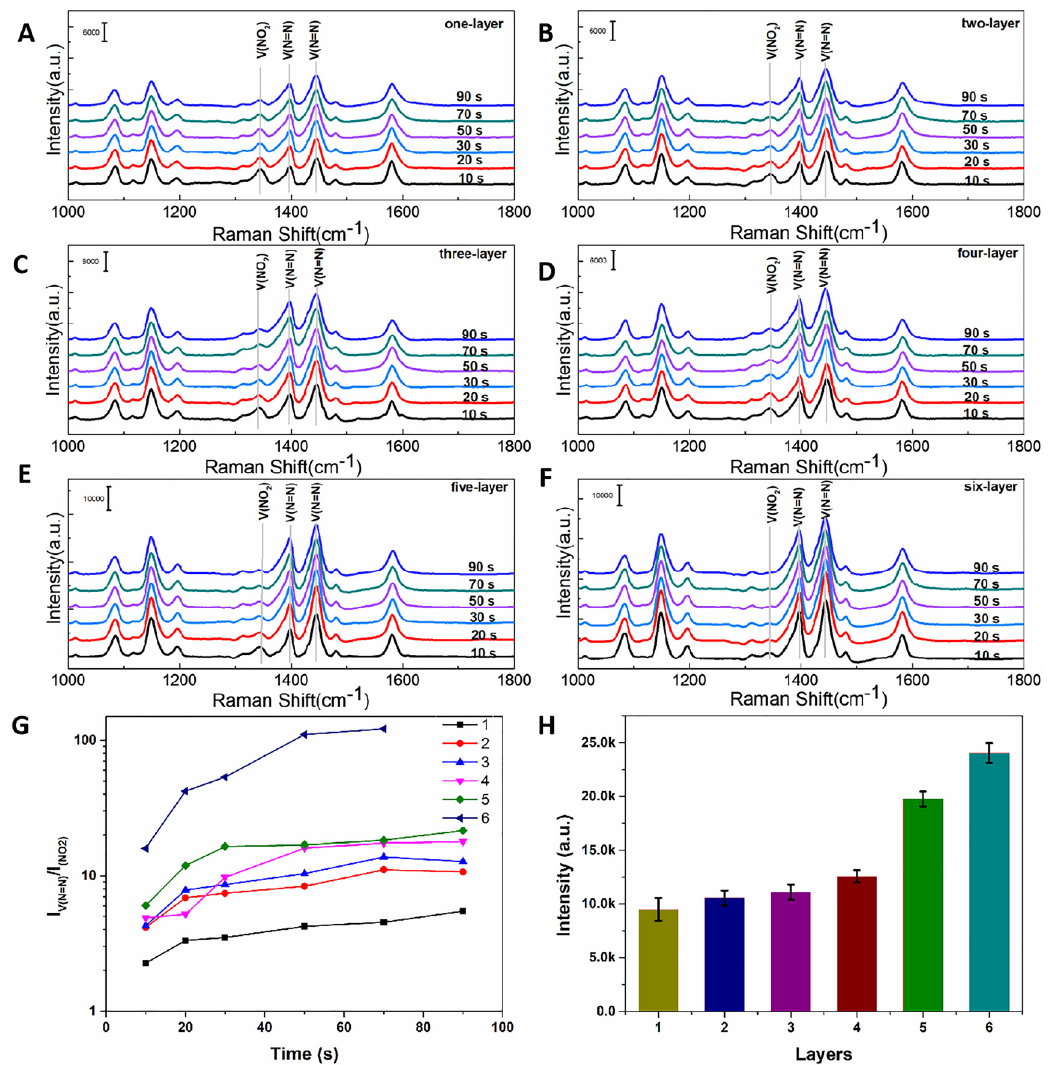
Figure 4: (A) – (F) The dual function of the catalytic activity and in situ surface-enhanced Raman spectroscopy (SERS) monitoring the reaction process of p-nitrothiophenol (PNTP) dimerizing into p,p ′ -dimercaptobenzene (DMAB) for MAgNP-CuF. (G) Time-dependent SERS intensity ratiosofthe v (N=N)and v (NO 2 )bandsforMAgNP-CuFwithdifferentAgNP/graphenelayersunder532nmlaserexcitation(0.48mW).(H)Layer- dependent SERS intensities of the ν (N=N)